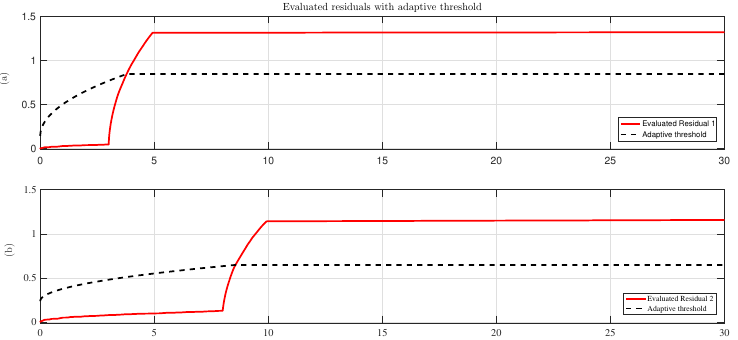
Figure 9. ( a ) Evaluated residual with adaptive threshold for Mode 1. ( b ) Evaluated residual with adaptive threshold for Mode 2.